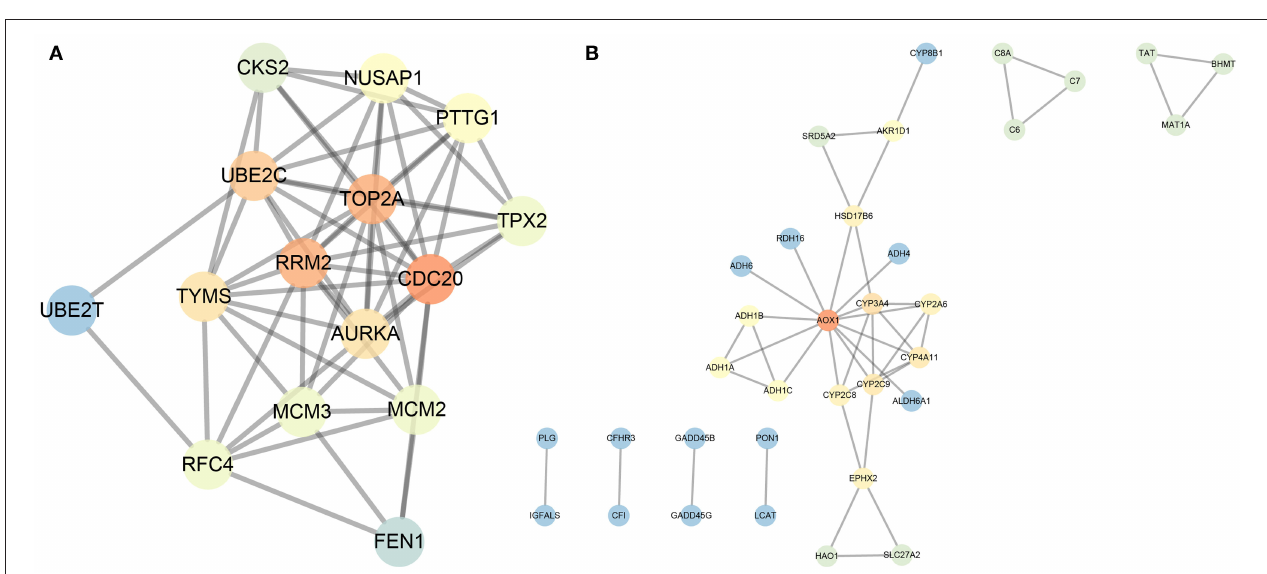
FIGURE 5 | Interaction analysis of the 18 prognosis-related upregulated genes and 70 prognosis-related downregulated genes. (A) , Gene interaction network of the 18 prognosis-related upregulated genes. (B) , Gene interaction network of the 70 prognosis-related downregulated genes. Each circle represents a gene, and the lines between circles indicate that there is interaction between the genes. The darker the circle, the higher the centrality of the gene in the network, and the greater the degree.